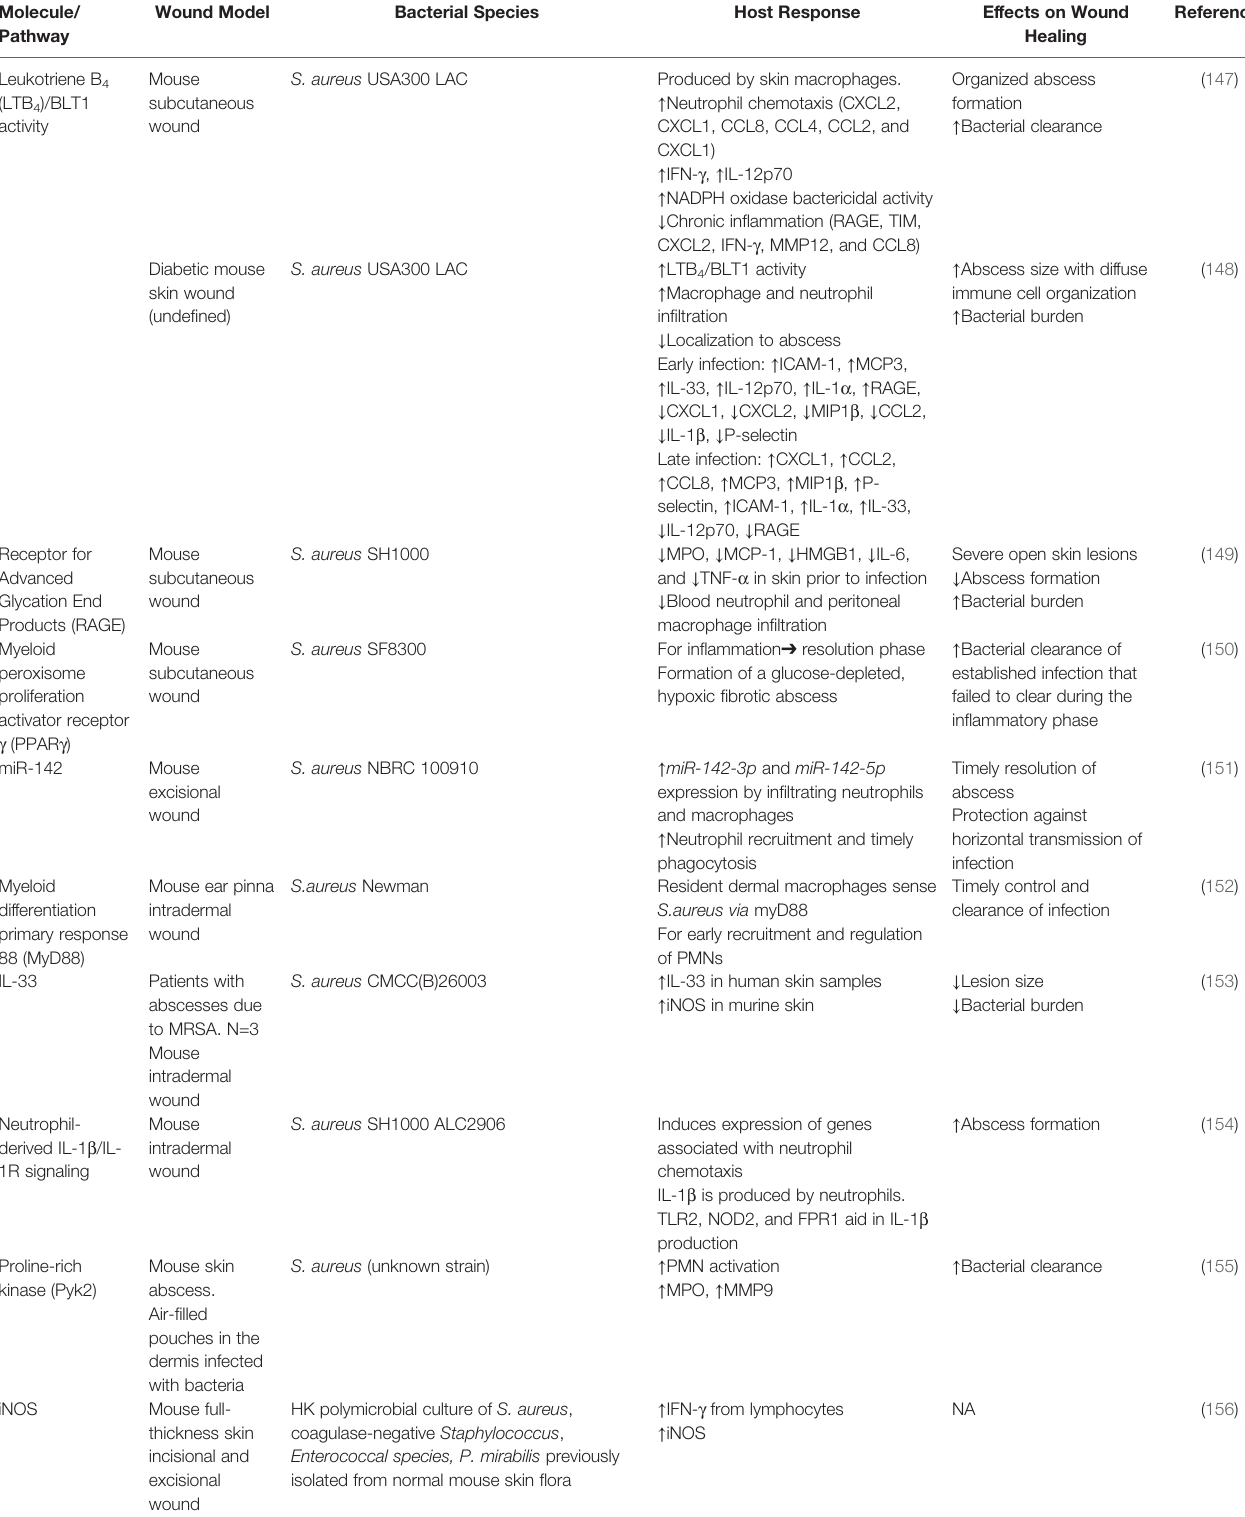
TABLE 3 | Summary of molecules and pathways that regulate the in fl ammatory responses to bacteria in